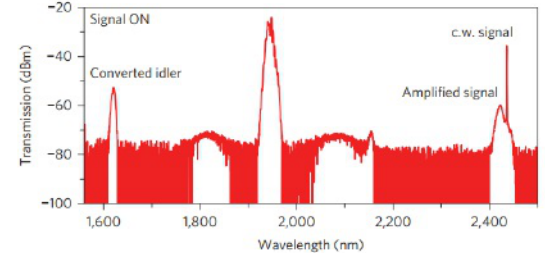
Fig. 16. The output spectrum after the signals (1946 nm pump pulses and a 2440 nm CW signal) have propagated through the silicon waveguide. In this case, the mid-infrared CW signal is converted to the telecom wavelength band. Adapted from refer- ence [63].